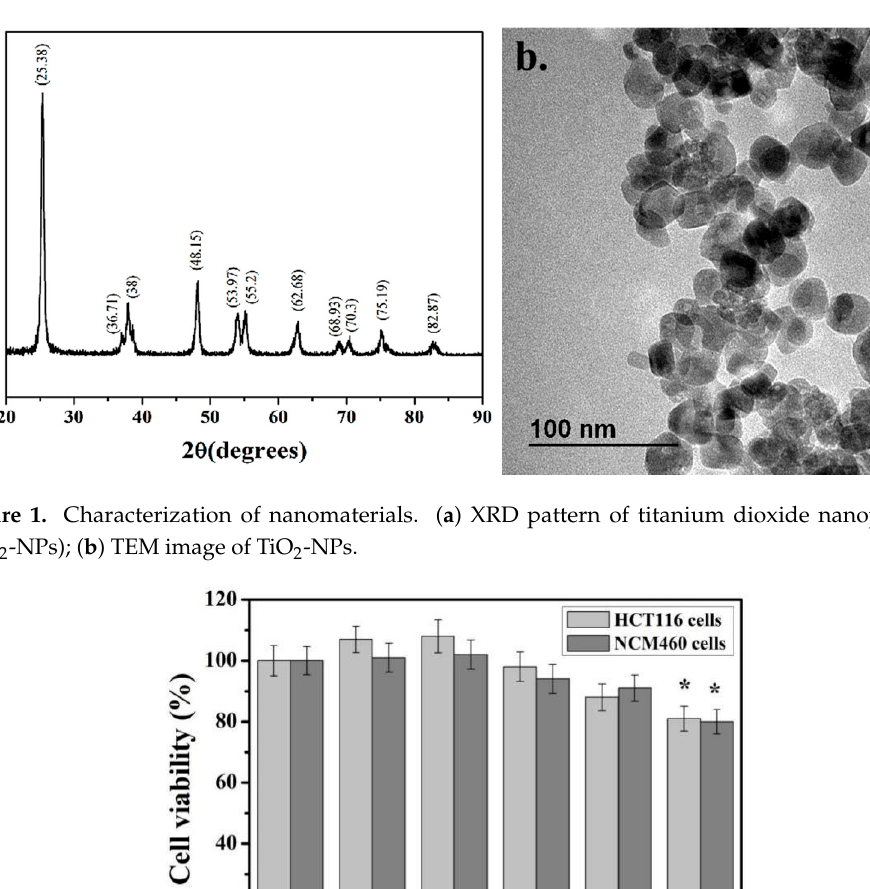
Figure 1. Characterization of nanomaterials. ( a ) XRD pattern of titanium dioxide nanoparticles (TiO 2 -NPs); ( b ) TEM image of TiO 2 -NPs.